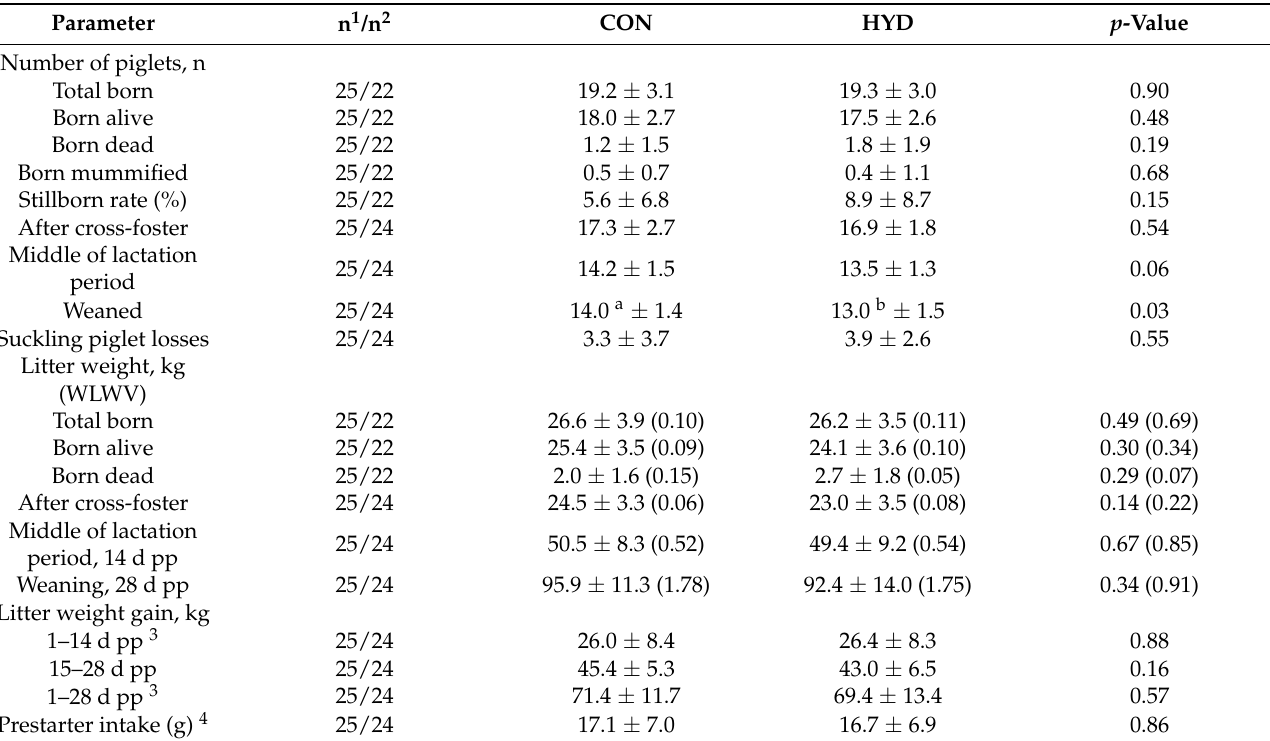
Table 7. Effect of dietary vitamin D source on reproduction parameter of sows (mean ± SD).